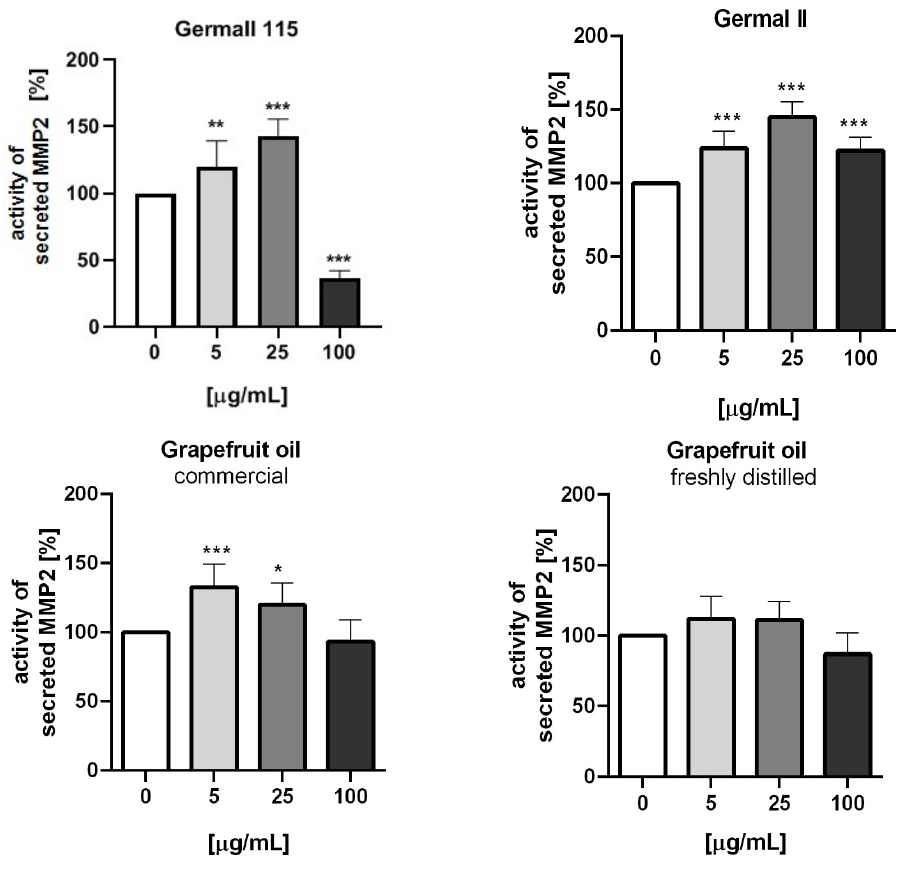
Figure 4. Activity of secreted MMP-2 by fibroblasts (BJ) stimulated by different doses of the most interesting preservatives. Values represent the mean (% of control) ± SD; n = 3, one-way ANOVA. *, p < 0.05; **, p < 0.01; ***, p < 0.001.